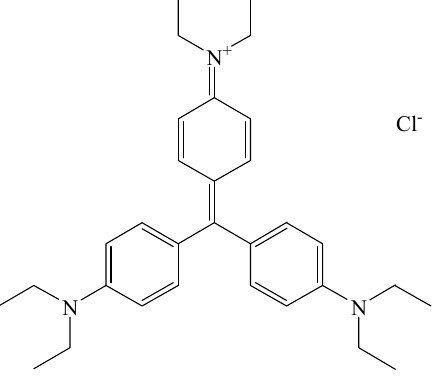
Figure 1. Chemical structure of cationic ethyl violet dye.